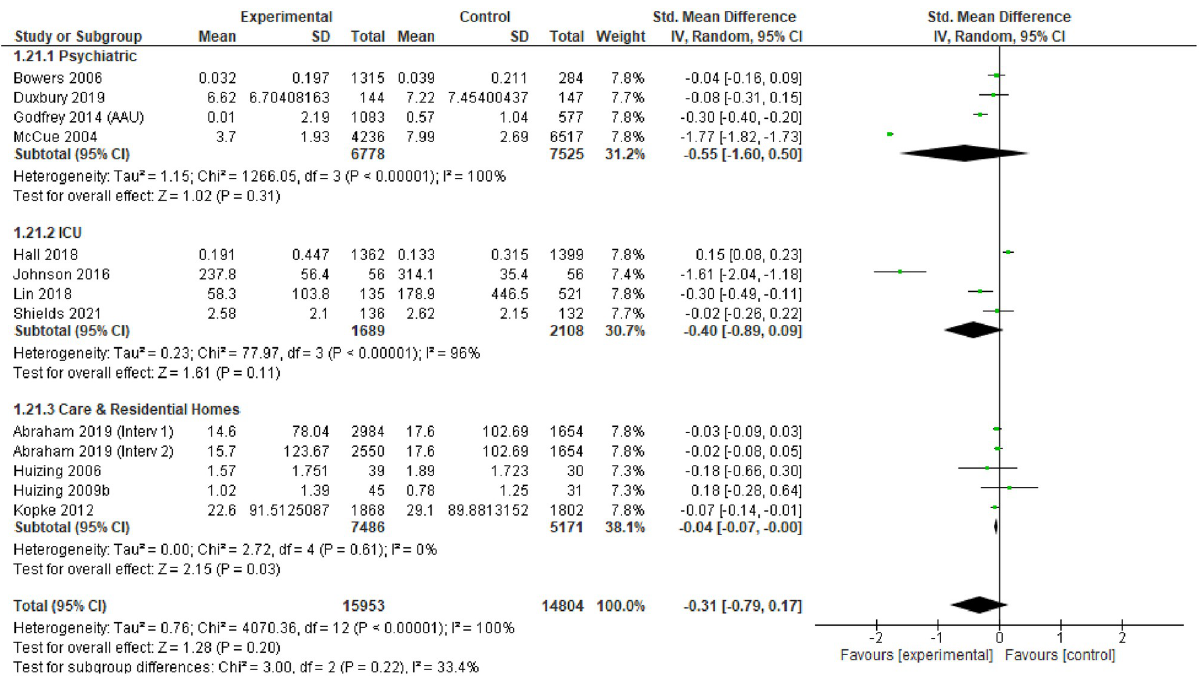
Fig 7. Effectiveness of interventions on the use of restraint by setting of care, excluding outliers.